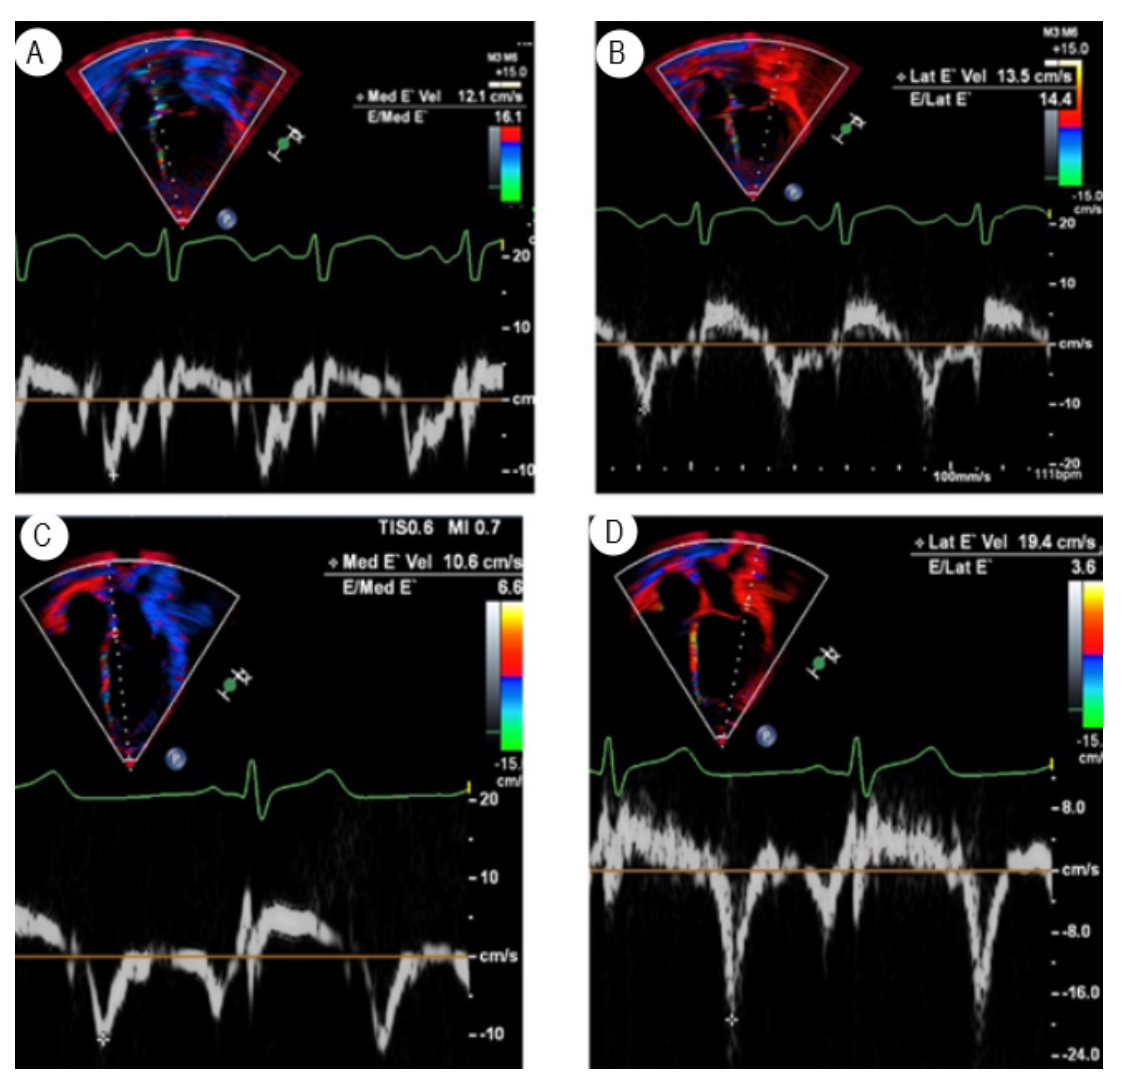
Figure 2. ( A ) TDI of the medial mitral annulus and ( B ) lateral annulus of the mitral valve in a six-year-old female three months post-transplant, showing diastolic dysfunction. E/e’ at medial mitral annulus 16.1 and at lateral annulus 14.4. ( C , D ) show the normal TDI at the medial and lateral annulus of the mitral valve in another 6-yr-old HT recipient who is doing well.